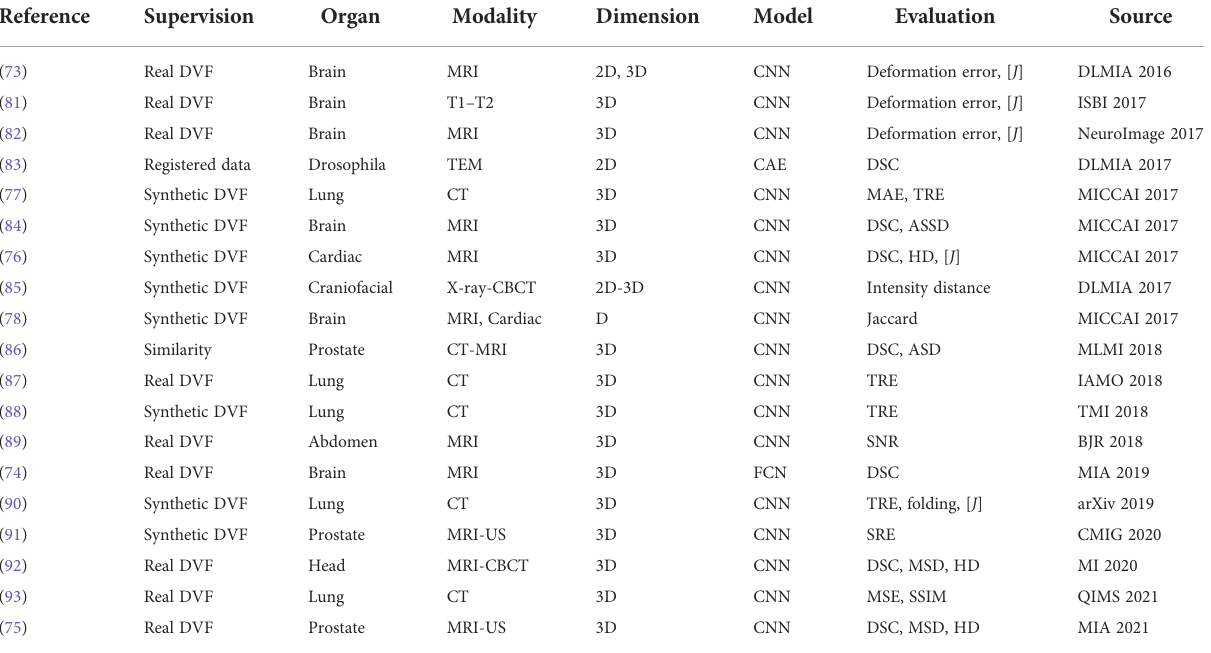
TABLE 3 Fully supervised medical image registration methods.